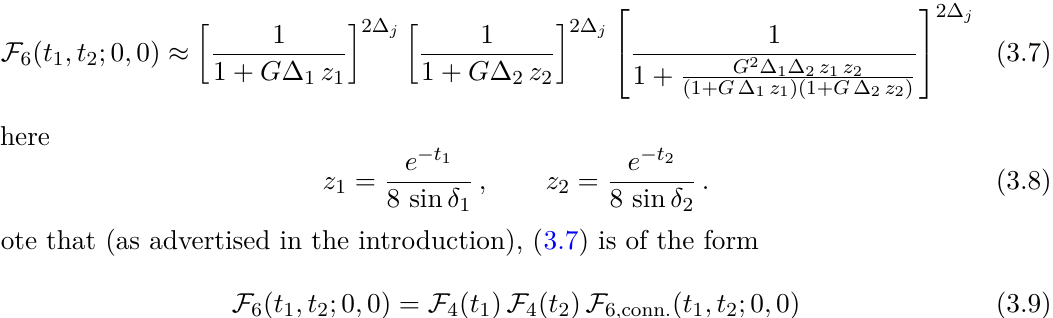
and − t . We set ∆ = 2 , ∆ = 0 . 05 , and 1 ∼ t ∗ 2 ∼ t ∗ 1 , 2 j